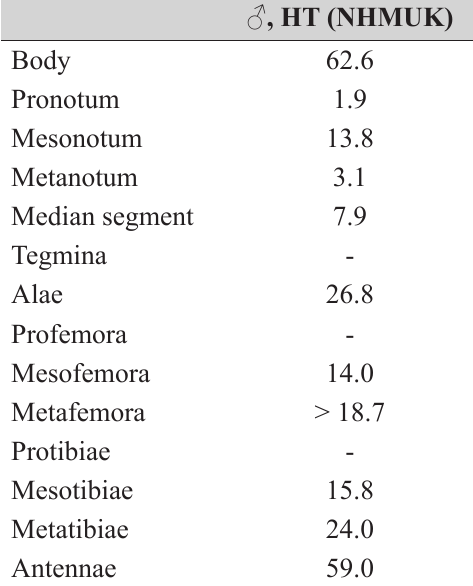
Table 8 . Measurements of Phantasca phantasma (Westwood, 1859) (in mm). HT =